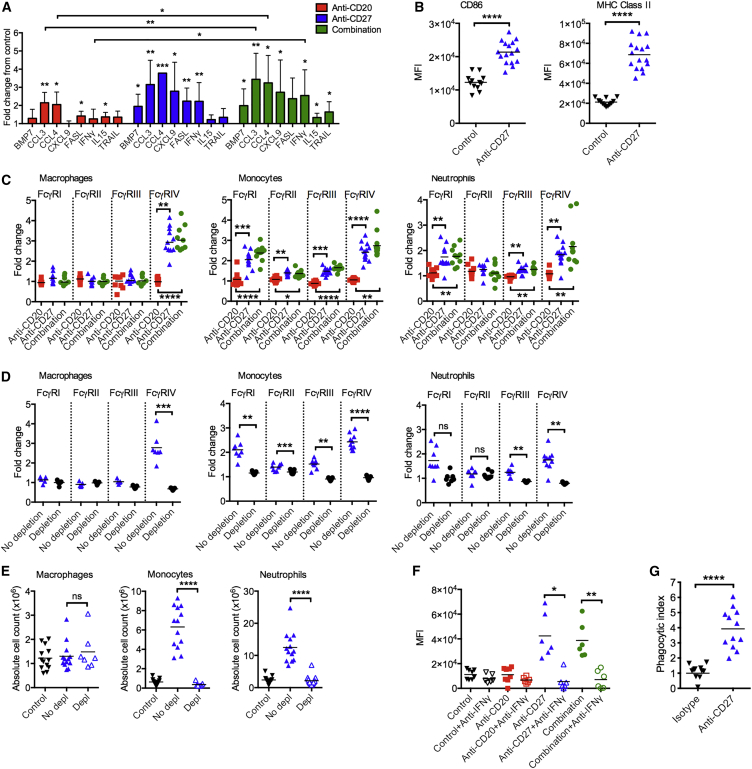
The Effect of Anti-CD27 on Macrophages(A) Naive mice were treated as described in Figure 2A, spleens were harvested on day 9, and RNA was extracted for cytokine and chemokine profiling. The graph is a summary of the genes that are significantly upregulated over the control sample. Means and 95% confidence interval limits shown.(B) CD86 and MHC class II expression on splenic macrophages in naive mice treated with isotype control or anti-CD27. MFI values are shown. Means are shown, n = 12–16/group.(C) BCL1-bearing mice were treated as previously described, and myeloid cells were harvested on day 13 and FcγR expression assessed. The fold change of MFI values over isotype-treated mice are shown. Means are shown, n = 7–11 per group.(D) Tumor-bearing mice treated with isotype control or anti-CD27 mAb therapy as previously described were not depleted (No depletion) or simultaneously depleted of T and NK cells (Depletion). Myeloid cells were harvested on day 13, and FcγR expression was assessed. The fold change of MFI values over isotype-treated mice are shown. Means are shown, n = 7–10 per group.(E) Mice were treated as in (D). Absolute numbers of myeloid cells in the spleen of isotype control, combination treated (No depletion), and combination treated (T and NK depletion) are depicted. Means are shown, n = 7–13 per group.(F) Tumor-bearing mice were treated with isotype control, anti-CD20, anti-CD27, or in combination, with or without an IFNγ-neutralizing mAb. Splenocytes were harvested on day 13, and FcγR expression was examined on macrophages. n = 6–8 per group.(G) Naive mice were treated with an isotype control or anti-CD27, and peritoneal macrophages were harvested on day 13. Macrophages were co-cultured with carboxyfluorescein succinimidyl ester (CFSE)-labeled huCD20 tg B cells opsonized with an isotype control or anti-CD20 for 1 hr, and CFSE and F4/80 double-positive cells were examined. The phagocytic index is shown. Means are shown, n = 12.Wilcoxon test was used to analyze p values in monocytes and neutrophils in (C) and (E–G), and Student’s t test for the remaining data; ∗p < 0.05, ∗∗p < 0.01, ∗∗∗p < 0.001, ∗∗∗∗p < 0.0001. See also Figure S4.